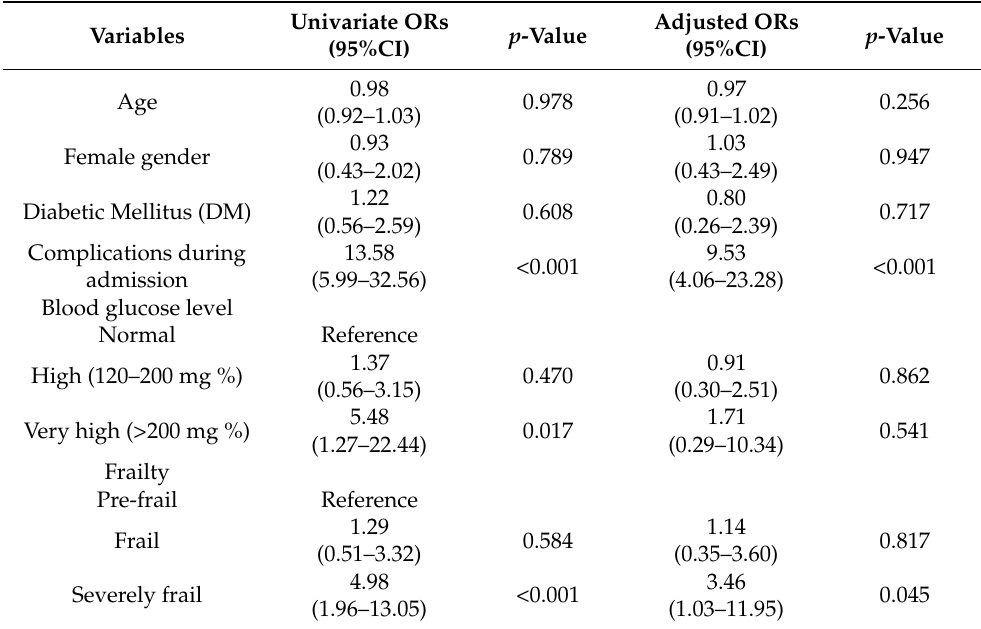
Table 3. Firth’s logistic regression analysis of factors influencing postoperative lower urinary tract in- fections in older adults undergoing noncardiac surgery, after controlling for other variables (N =